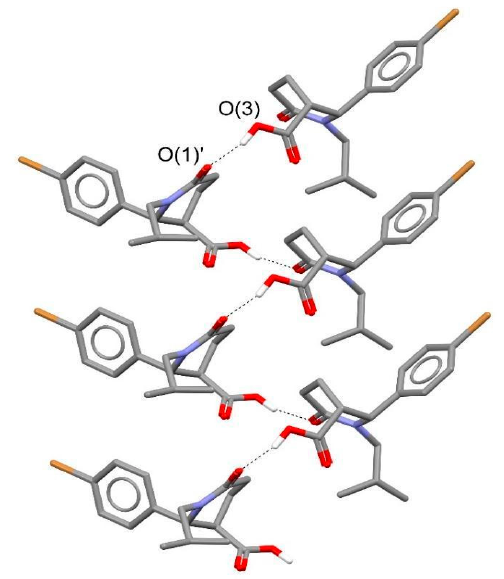
Figure 7. A simplified sketch showing the symmetrically equivalent intermolecular O-H ··· O hydrogen bonds (dashed lines) occurring in the crystal of the ( + )-(2 R ,3 R )- 1 compound (atom names are reported only for O atoms involved in the H-bond, hydrogens not involved in the H-bonds are omitted for clarity).